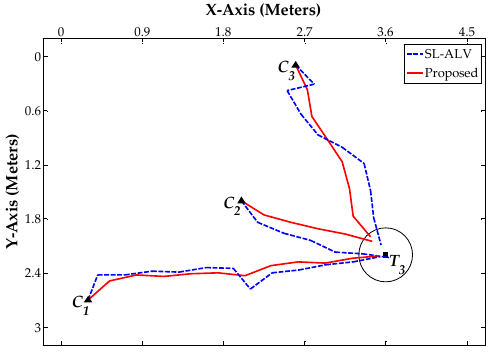
Figure 15. Homing Experiment 2. Table 5. Associated results of homing experiment 2. Figure 16. Homing Experiment 3. Figure 16. Homing Experiment Table 6. Associated results of homing experiment 3.